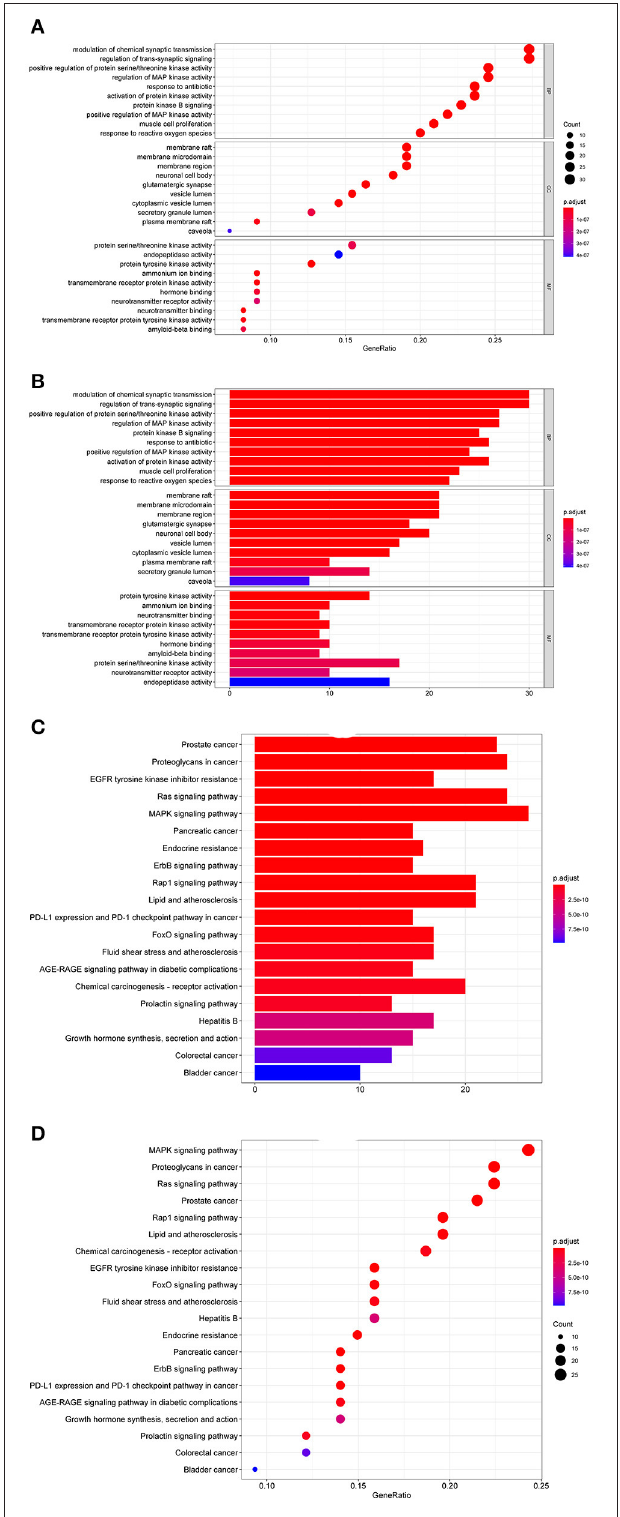
FIGURE 2 | (A) Bubble graph of GO enrichment analysis. (B) Bar chart of GO enrichment analysis. (C) Bar chart of KEGG enrichment analysis. (D) Bubble graph of KEGG enrichment